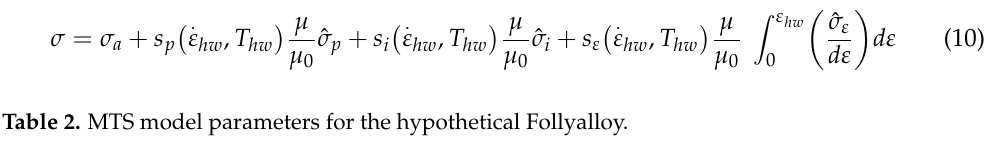
Equations (1) and